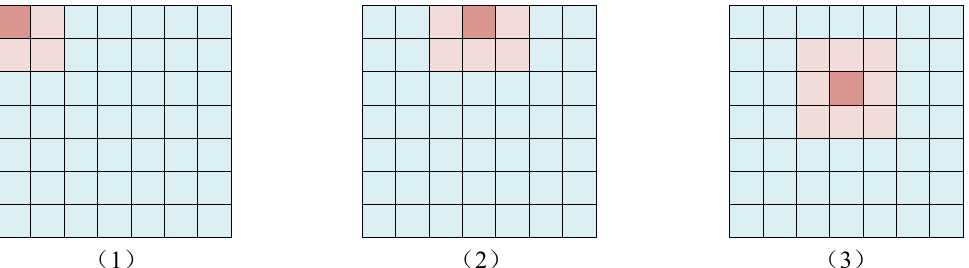
Figure 3. The weight distribution of stair attention in three cases. Different colors represent different weight